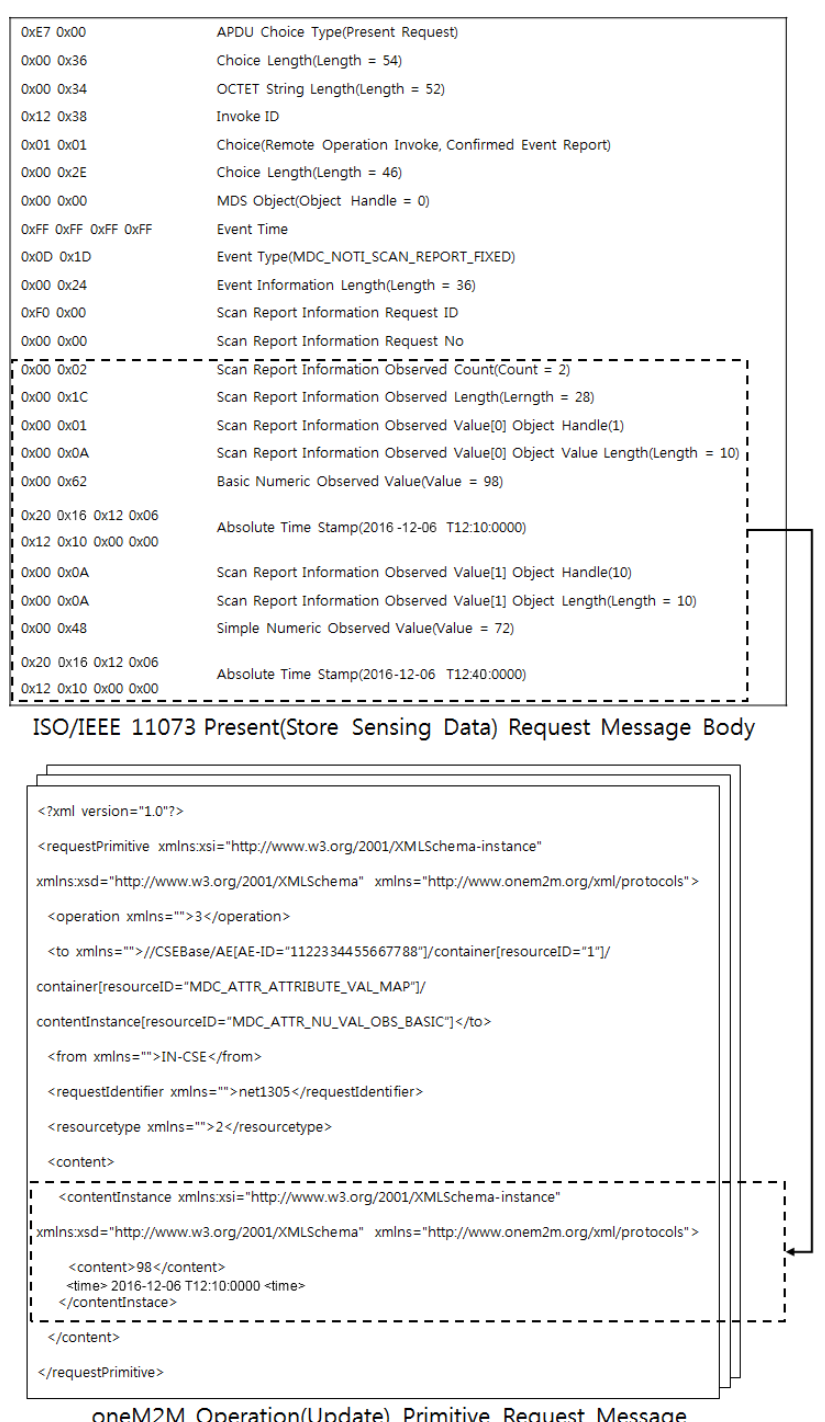
Figure 12. An example of the process described in Figure 11.